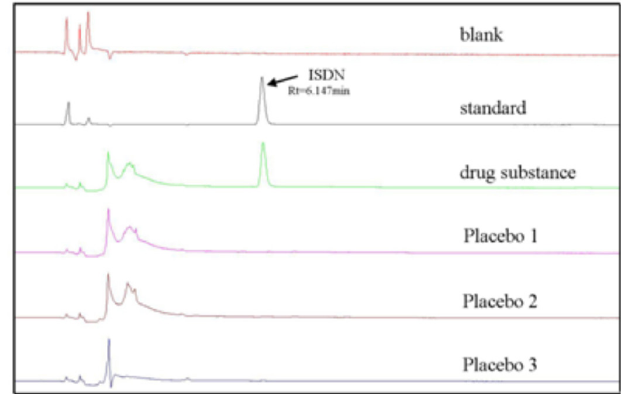
FIGURE 4 – Chromatograph from HPLC obtained from different sample solutions.